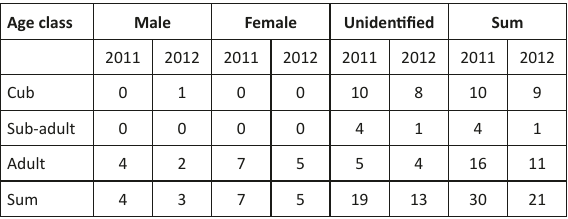
Table 1. Age/sex structure of identified Brown Bears- summers